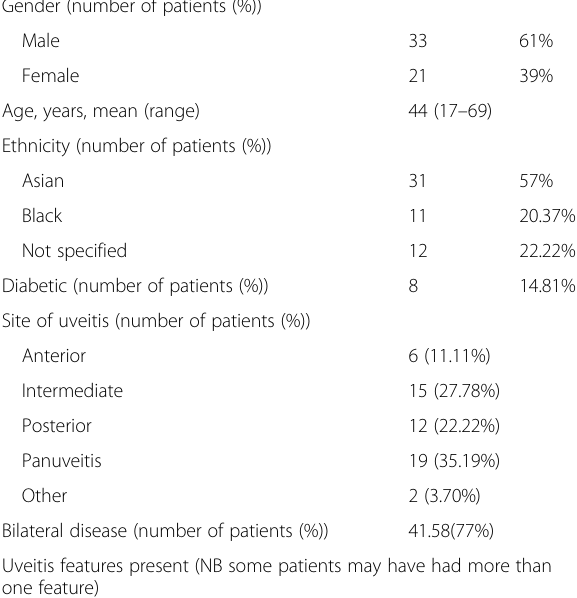
Table 1 Characteristics of the patient